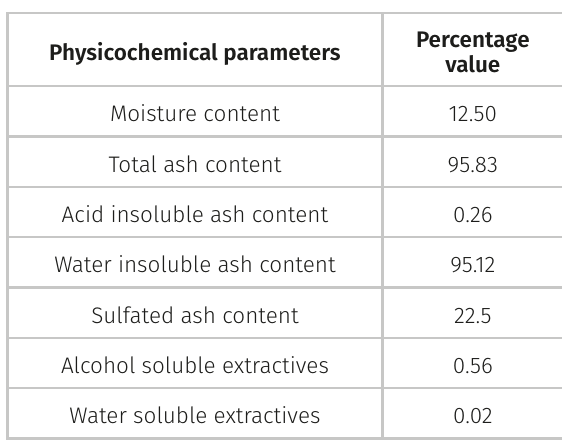
Table III. Physicochemical analysis of crude powder of S. hispanica